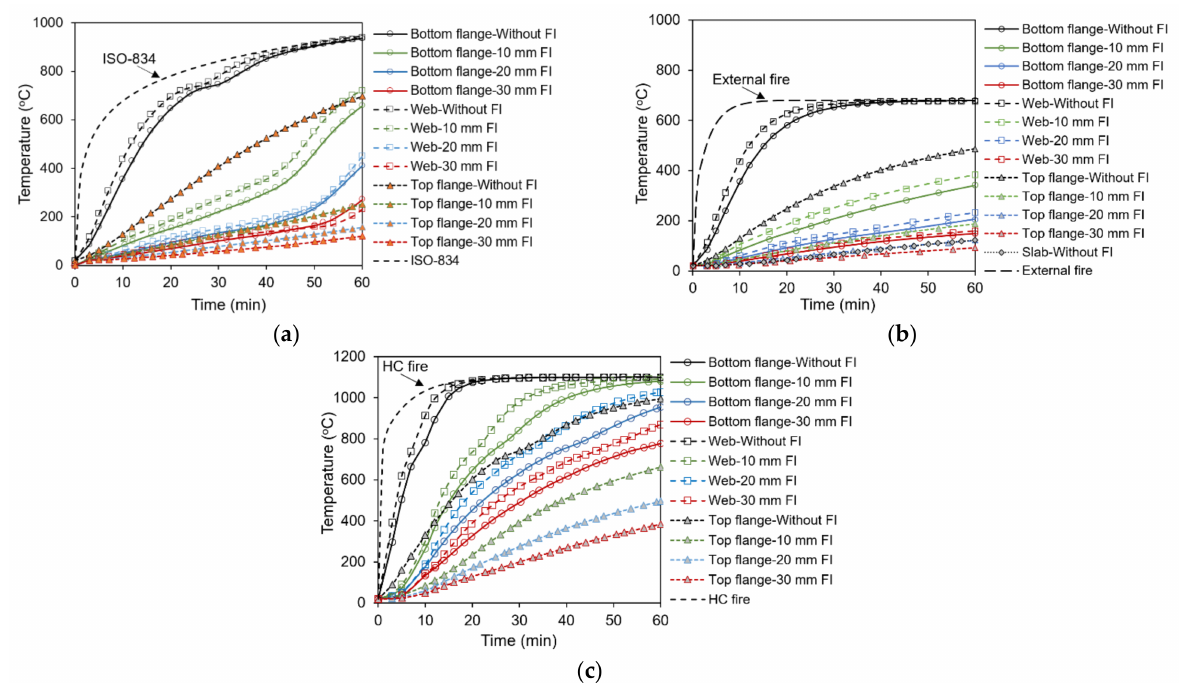
Figure 12. Temperature distribution in steel beam: ( a ) ISO-834 fire; ( b ) External fire; ( c ) Hydrocarbon fire.